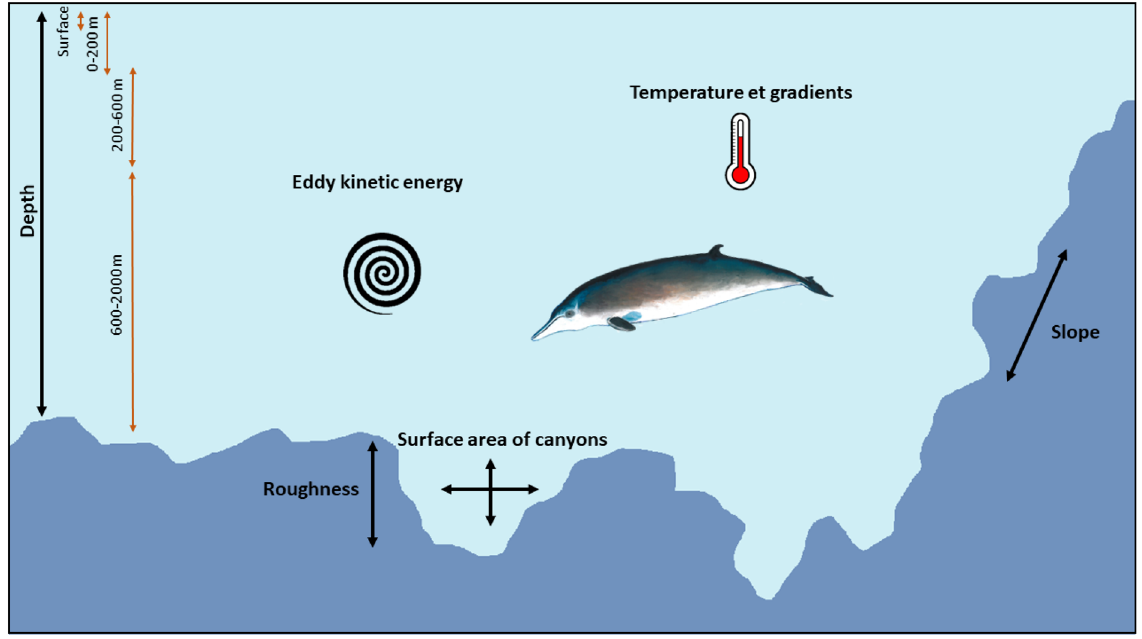
Figure 5. Schematic representation of environmental variables used in habitat-based density models and depth classes. Orange arrows represent the four depth classes (Surface, 0–200 m, 200–600 m and 600–2000 m) and environmental variables are written in